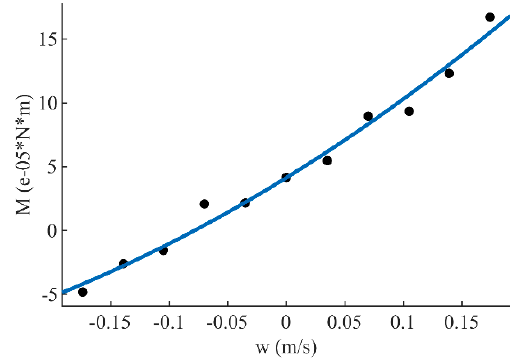
Figure 8. Fitted curve of yaw moment M and line speed w.